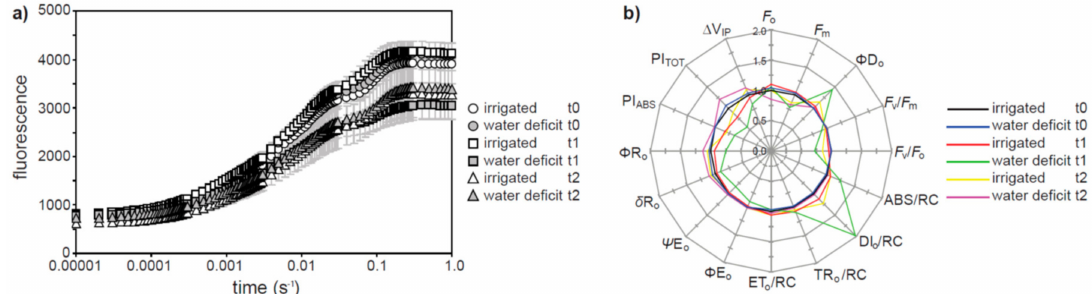
Figure 4. Analysis of the chlorophyll fluorescence transient of olive plants at t 0 (circle symbol), t 1 (square symbol) and t 2 (triangle symbol) (see Figure 1 for sampling intervals) subject to full irrigation (white fill symbols) and water deficit (grey fill symbols) treatments: ( a ) average OJIP induction curves; ( b ) spider plot of parameters (see Materials and Methods for definitions and descriptions) extrapolated from the OJIP transient expressed in relation to values of plants receiving full irrigation at t 0 . Error bars indicate one standard deviation either side of the mean.